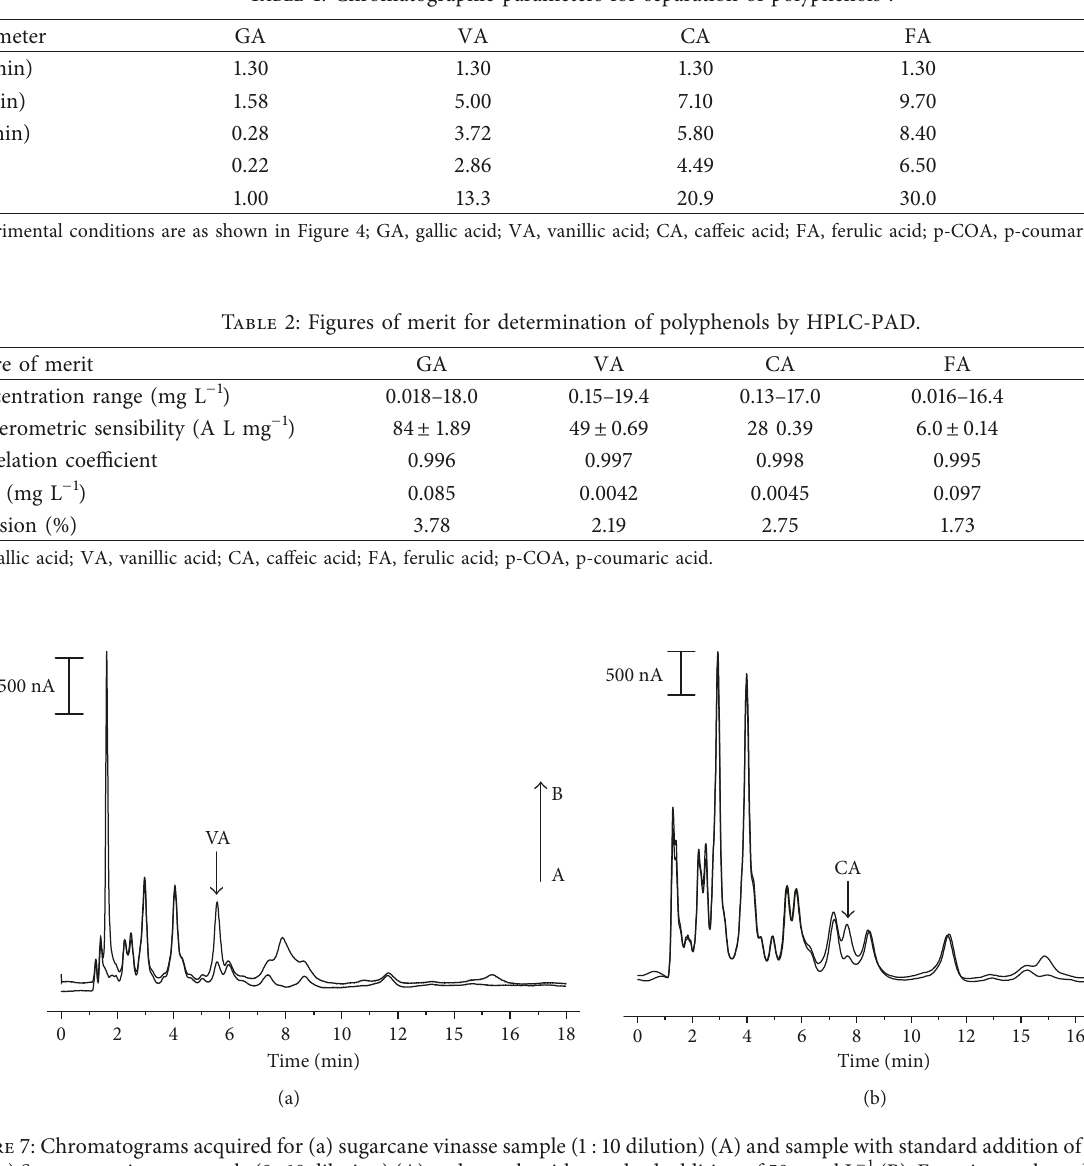
1 (B). Experimental conditions are as L · −